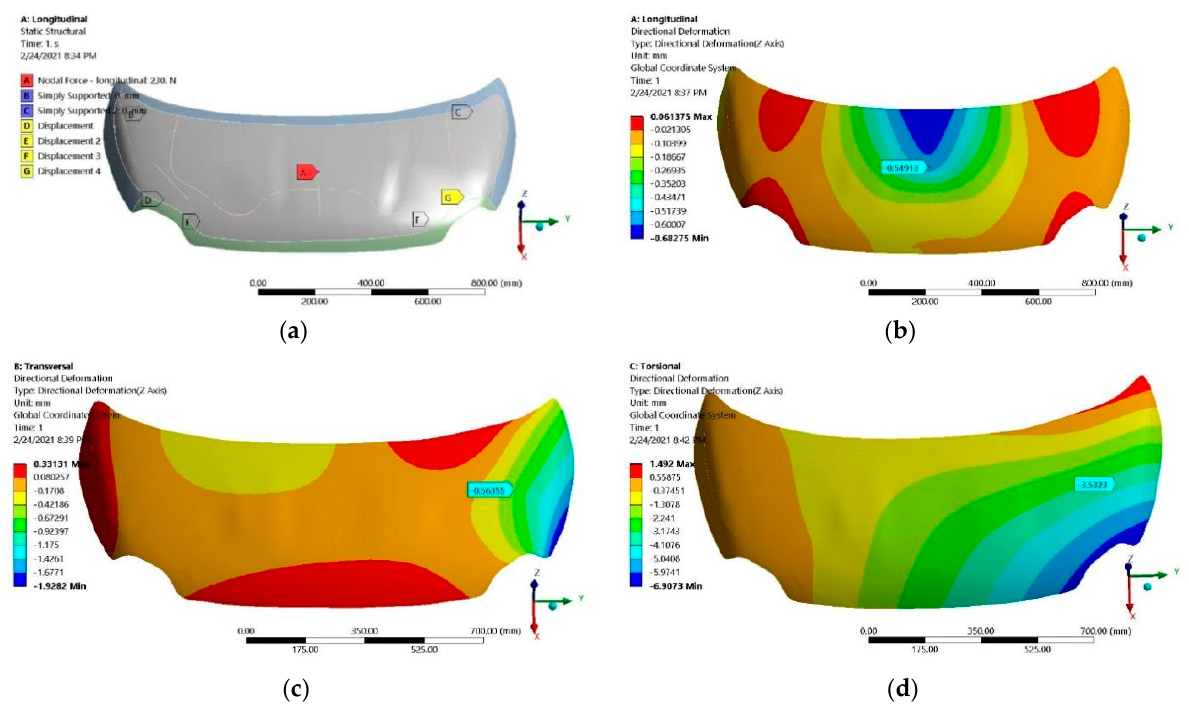
Figure 17. Numerical simulation of hood “B”: ( a ) boundary conditions for longitudinal loading case; ( b ) displacements— longitudinal; ( c ) displacements—transversal; ( d ) displacements—torsional.